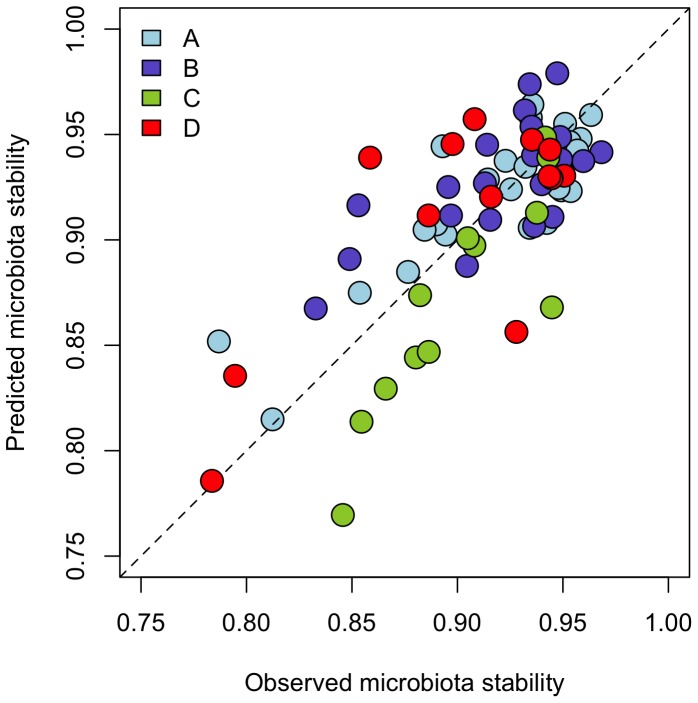
Validation of the microbiota responsiveness model.The model selection and validation were conducted four times, each time leaving out one study (marked with letters A-D). The resulting model was used to predict the stability values in the left-out study. The dashed line represents the ideal situation where observed  =  predicted.